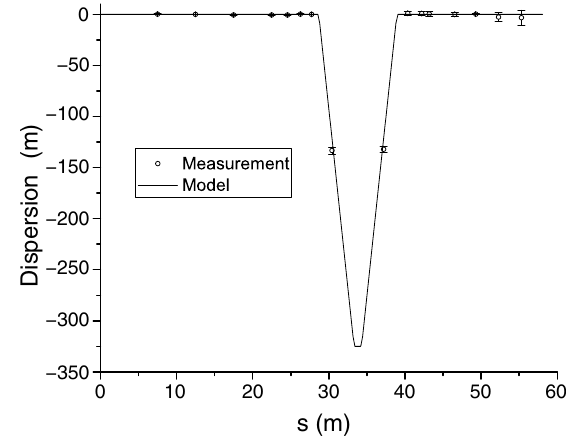
FIG. 57. Measured and modeled dispersion along the injector, with the bunch compressor angle set to